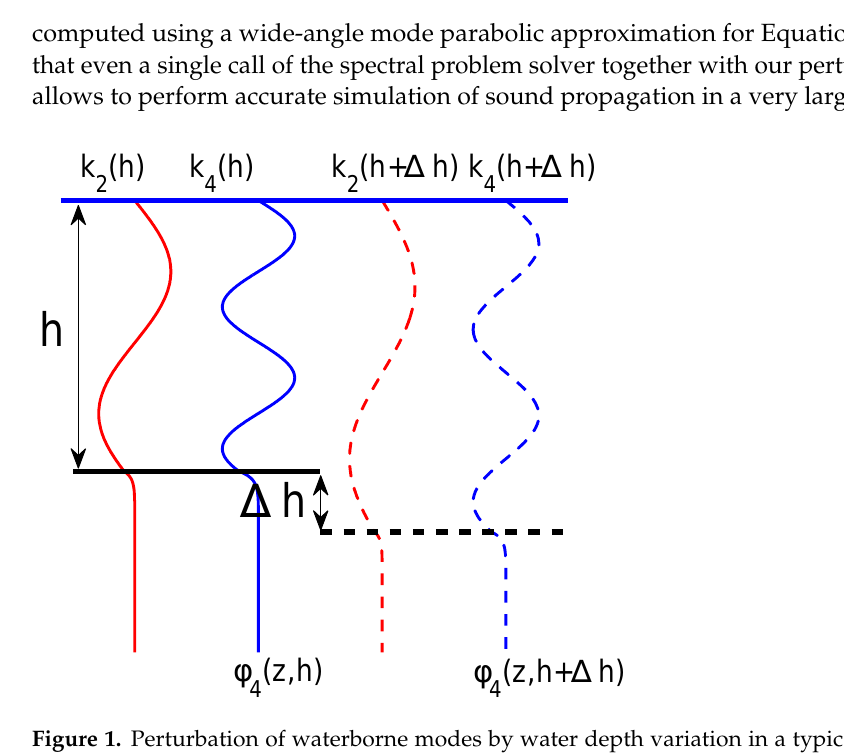
Figure 1. Perturbation of waterborne modes by water depth variation in a typical shallow-water waveguide with penetrable